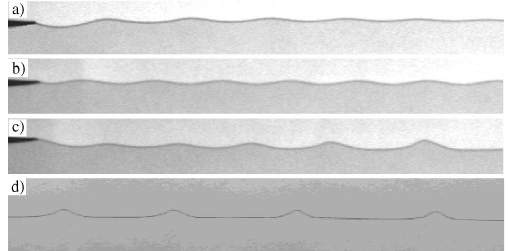
Figure 7. Reproduced from [16]. The experimental results are shown. As the wave propagates, its amplitude is either damped ( a ), or constant ( b ), or amplified ( c ), depending on the initial amplitude and on the injection velocity. When the wave is amplified, it eventually saturates to a cnoidal-like wave, as shown in a picture taken far downstream ( d ).